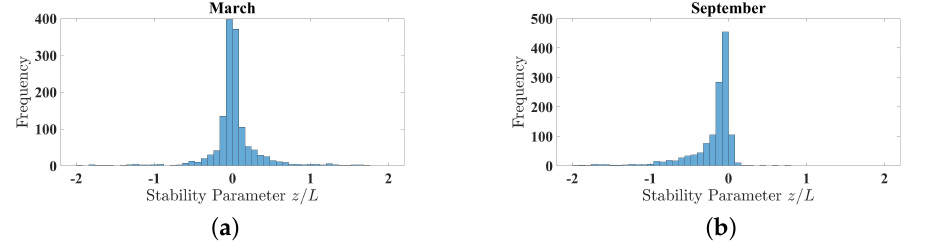
Figure 5. Histogram of stability parameter z / L for: ( a ) March, ( b ) September 2021.